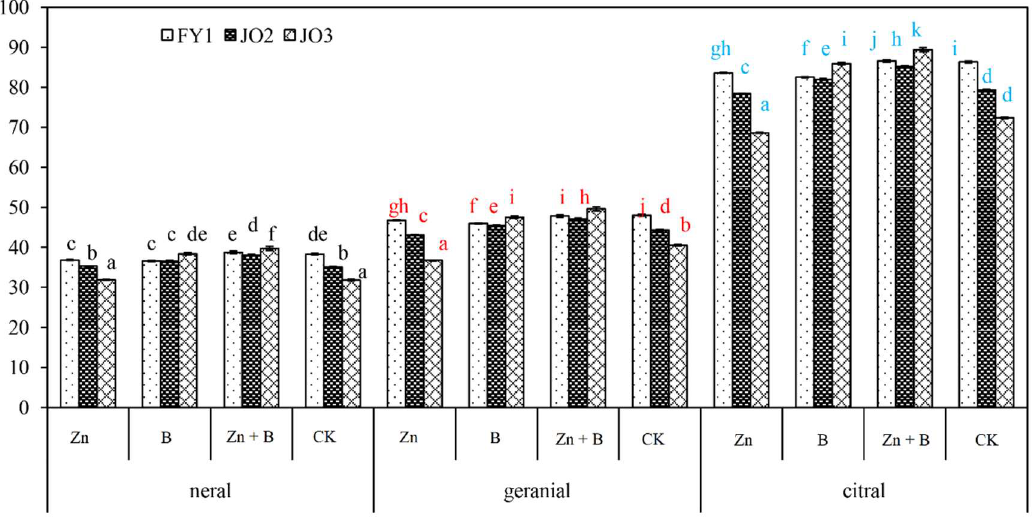
Figure 4. Effects of the foliar applications of micronutrient solutions on the neral, geranial, and citral content in L. cubeba . The letters in black indicate significant differences of neral from the different foliar applications of the nutrient solutions. The letters in red indicate significant differences of geranial content from the different foliar applications of the nutrient solutions, and the letters in blue mean indicate differences of citral content from the different foliar applications of the nutrient solutions.